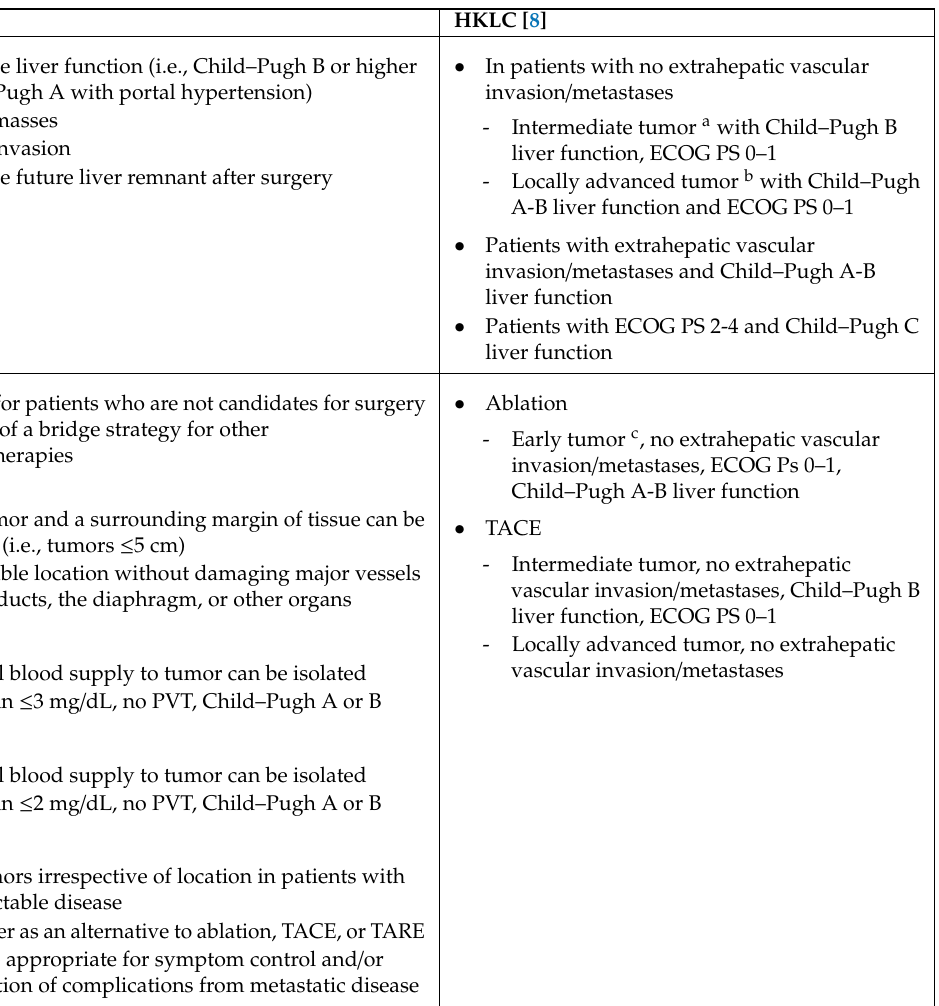
Table 1. Recommendations from selected guidelines for the treatment of patients with unresectable